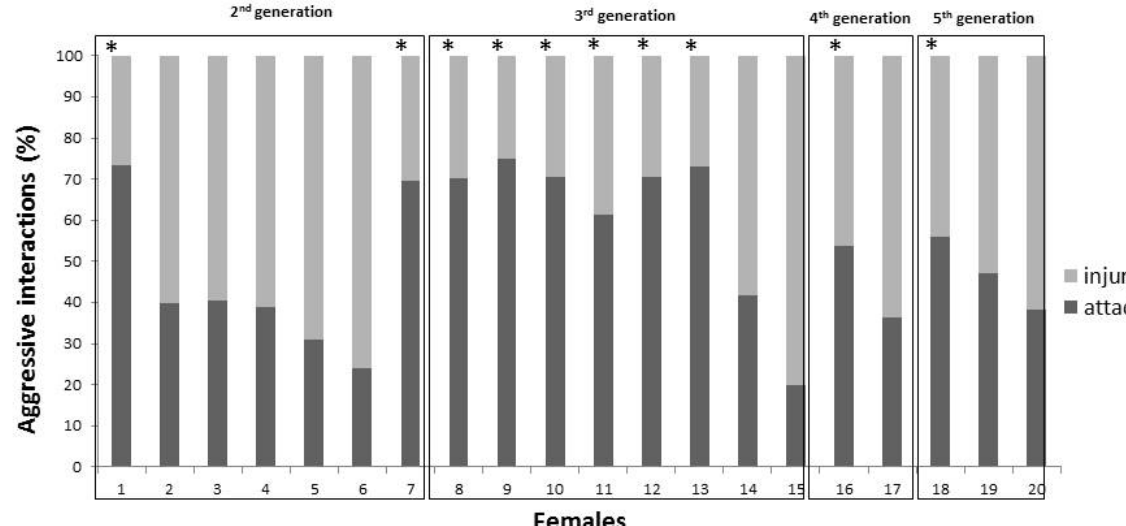
Fig 5. Agonistic interactions observed for 20 females of Euglossa annectans across four generations. The interactions were noted for seven females from the second generation, eight females from third generation, two females from the fourth and three females from the fifth generation. The dark grey bars show the number of attacks started by a given female (indicated from 1 to 20). The light grey bars indicate when the same female was attacked by another female. We found no significant difference when both events were compared, attack vs injury; paired t test (Mann Whitney U=190.500, n =n =20, p=0.799, 1 tailed). The symbol “*” indicates a potential dominant female and the bees with 1 2 no symbol indicate a potential subordinate female ( Mann Whitney U = 10.500, n = n =10 p = 0.002, 1 2